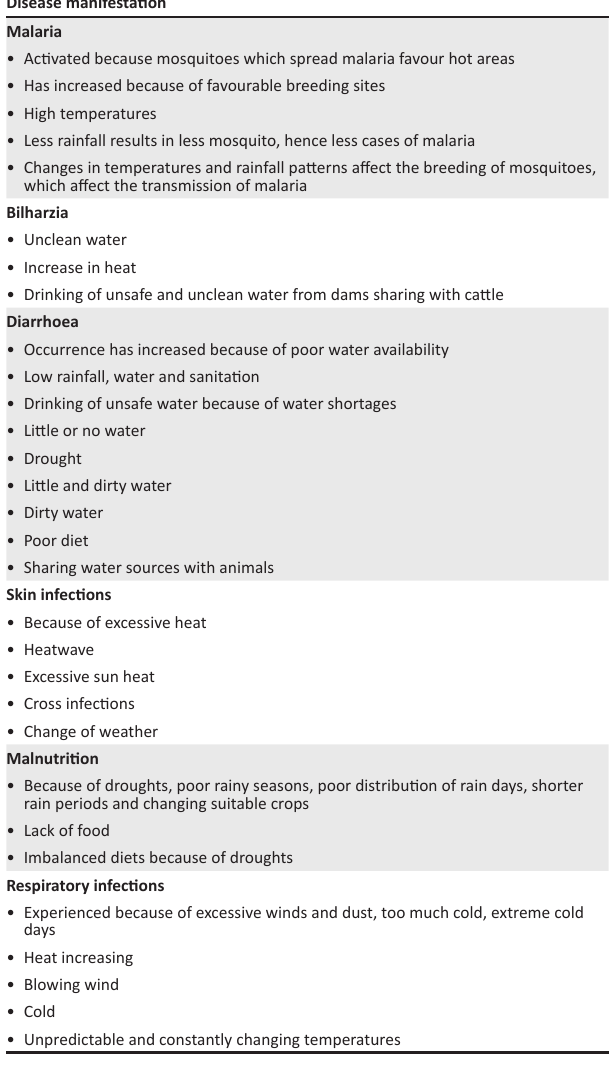
TABLE 4: Respondents’ perceptions of how climate change has altered the disease manifestation ( n = 204). Disease manifestation